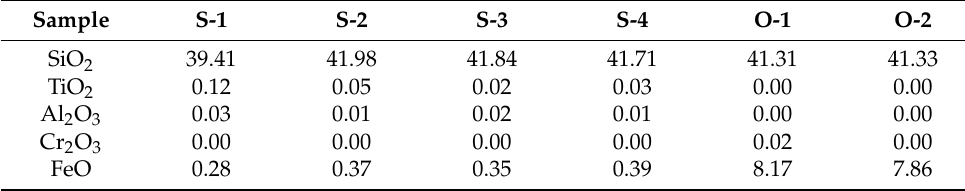
Table 1. Chemical composition of B-rich forsterite and mantle olivine.